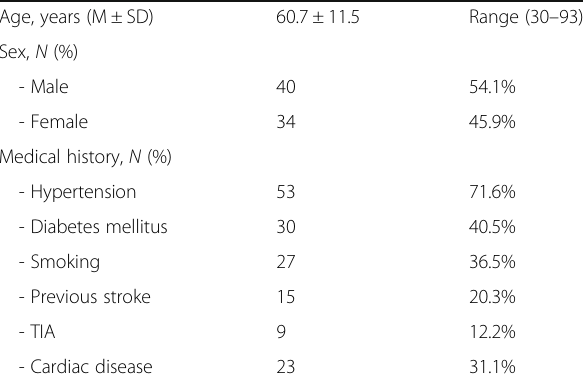
Table 1 The demographic data and medical history of the studied